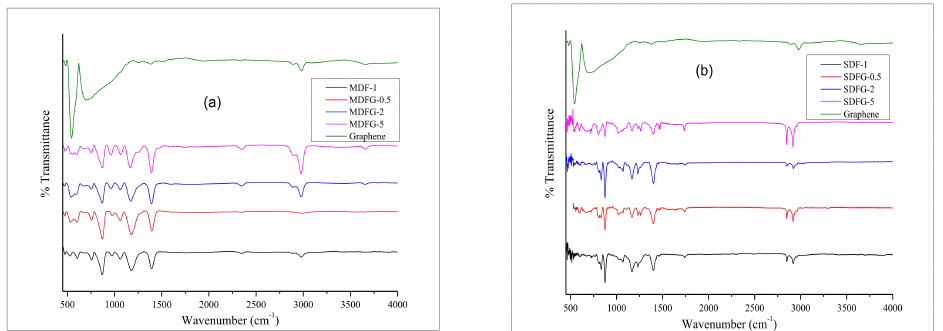
Figure 10. Overlay graphs of FRIT of nanocomposites prepared by: ( a ) melt-mix method, and ( b ) solution-cast